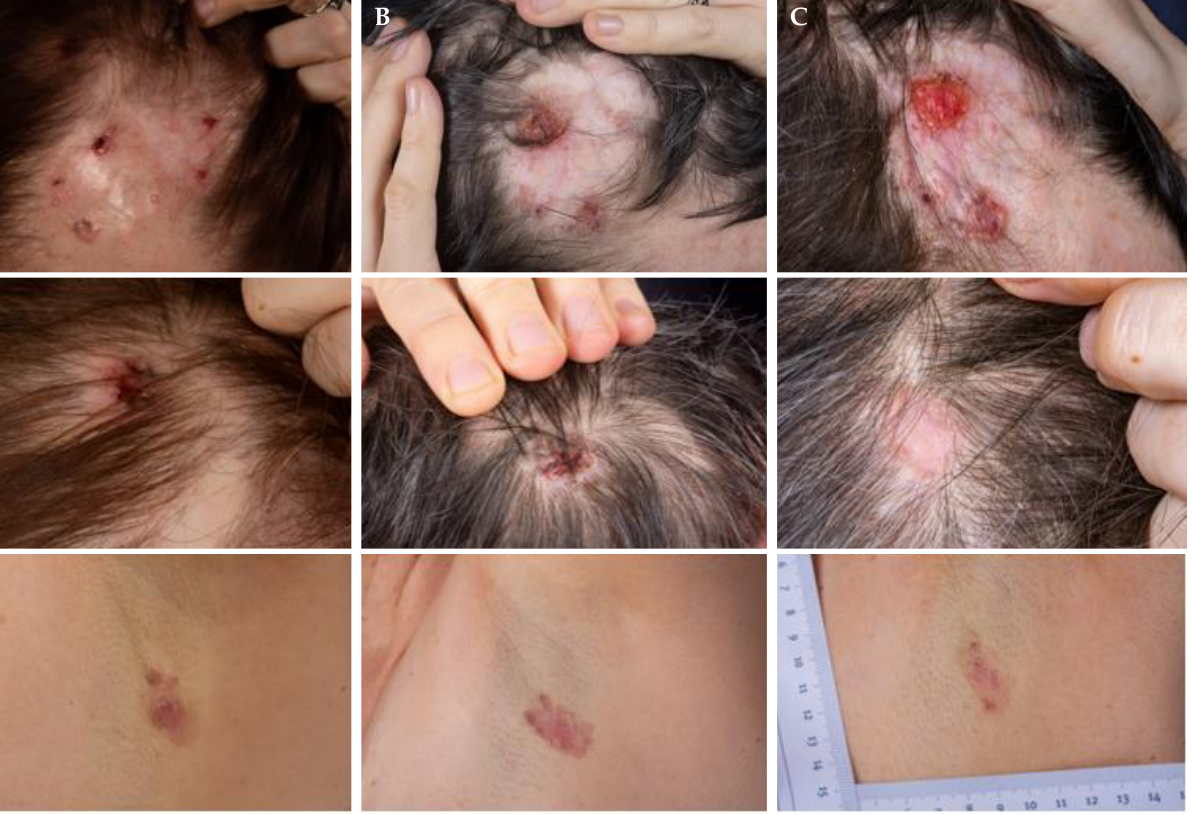
Figure 4. Case history of a patient with Gorlin – Goltz syndrome and multiple BCCs before pembrolizumab treatment ( A ), 7 months after pembrolizumab (at progression) and before sonidegib treatment ( B ), and 5 months after sonidegib treatment ( C ).